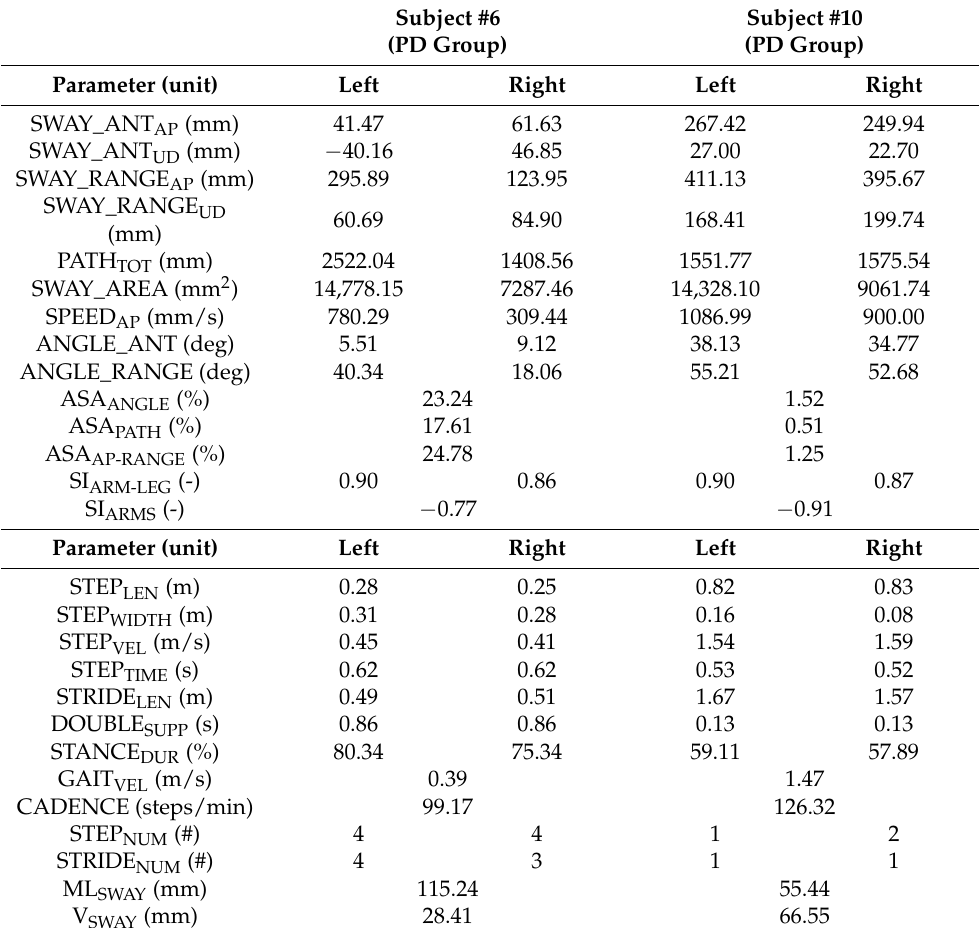
Table 6. A subset of the most representative parameters for the left and right sides related to the performance shown in Figure 2 (PD